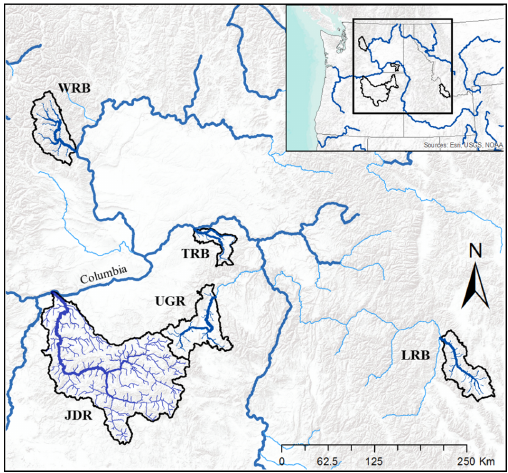
Figure 1. Interior Columbia River basins included in this analysis: JDR = John Day River, LRB = Lemhi River, TRB = Tucannon River, UGR = Upper Grande Ronde, and WRB = Wenatchee River. The map area extends from 43°30 ′ N to 49°18 ′ N latitude and 112°24 ′ W to 121°48 ′ W longitude.